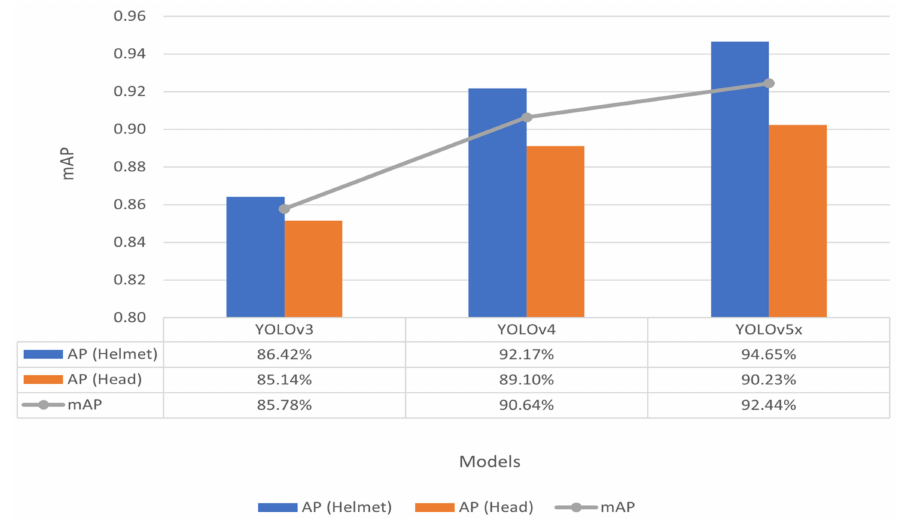
Figure 7. Mean Average Precision for Each Model. Table 2. Performance Assessment of YOLO models.